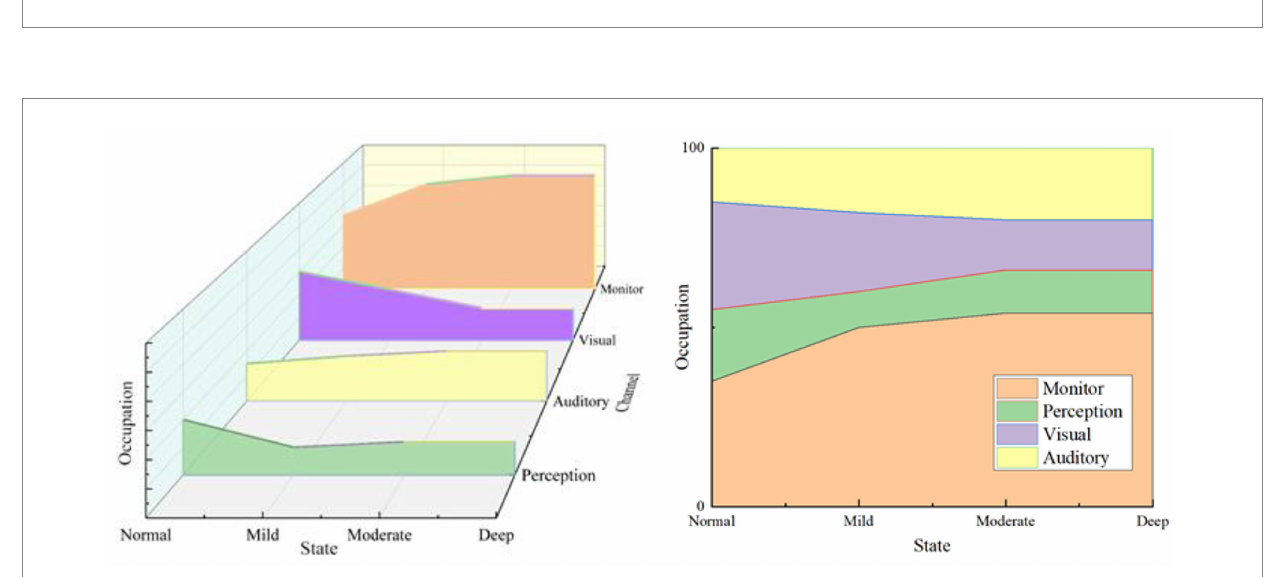
FIGURE 13 Schematic diagram of the occupancy trend of each channel under different driving states.